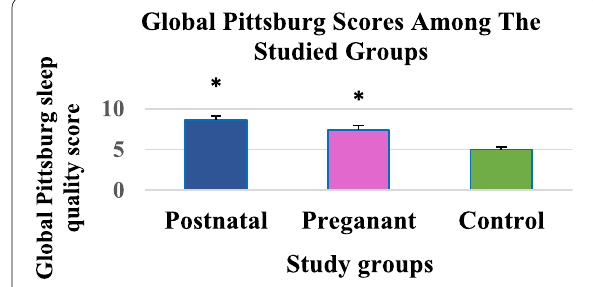
Fig. 2 Sleep quality global score in the studied groups. Data presented as mean standard error of the mean (SEM). * P < 0.05 in ± comparison with the control group